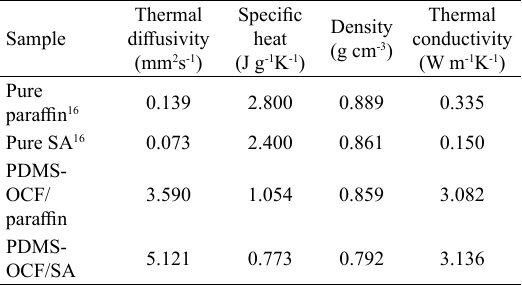
Table 2. Thermal conductivity properties of the